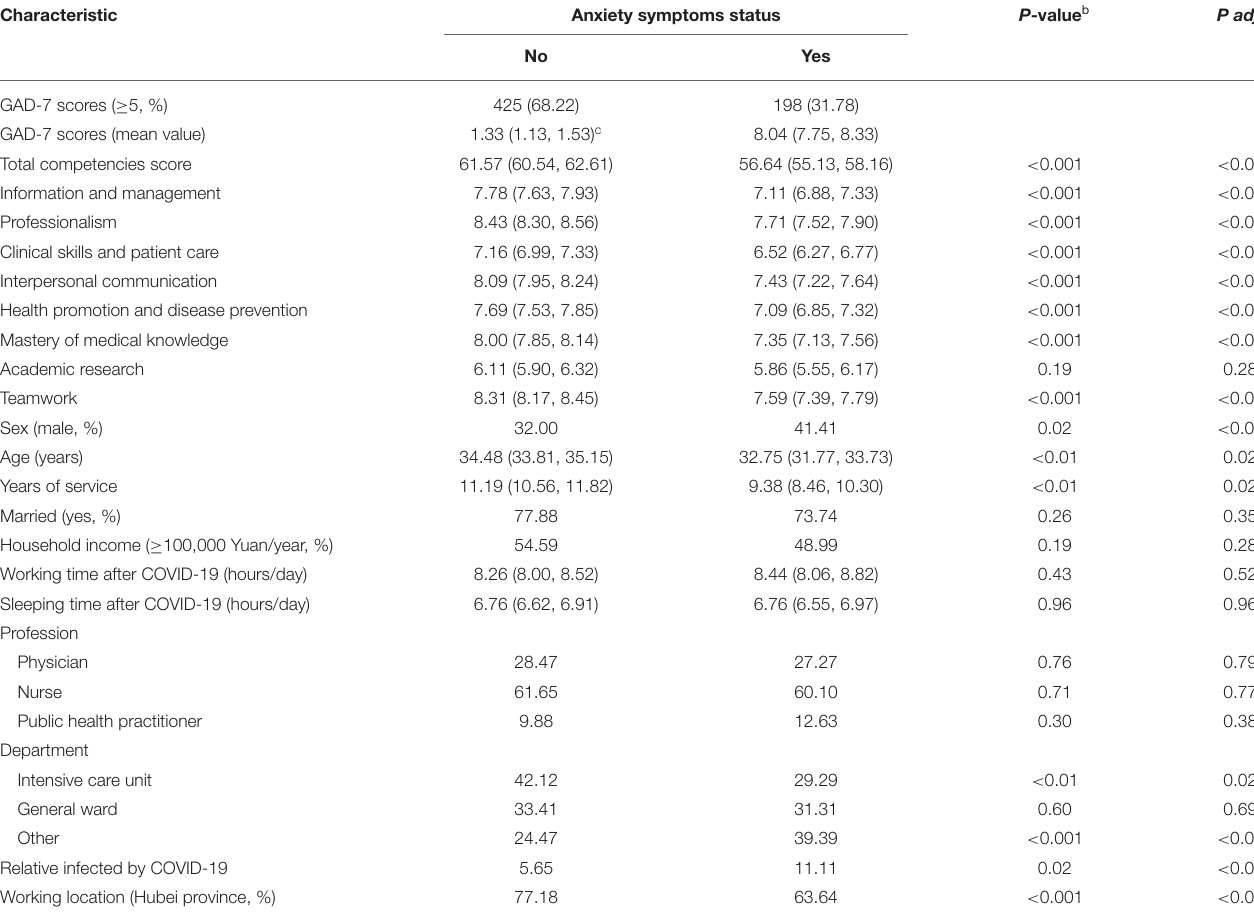
TABLE 2 | Participant characteristics, stratified by the presence of anxiety symptoms a . Characteristic Anxiety symptoms status P -value b P